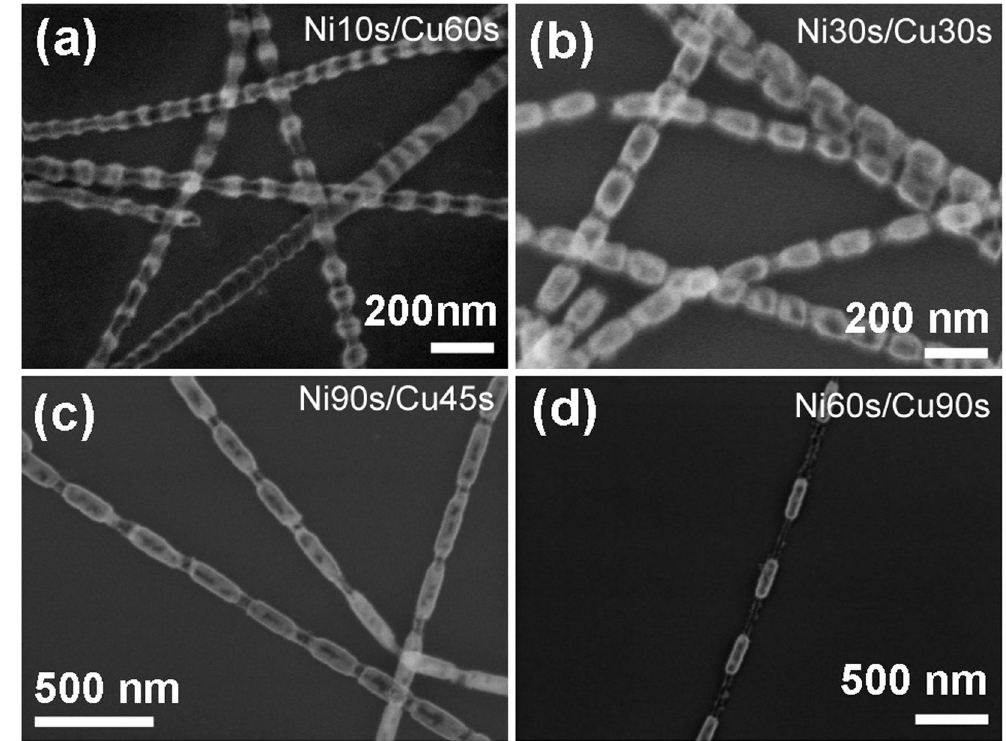
Figure 2. Morphologies of annealed samples with different segment lengths. FE-SEM images of the four kinds Ni/Cu samples after annealing at 700 °C for 2 h in air: ( a ) Ni10s/Cu60s; ( b ) Ni30s/Cu30s; ( c ) Ni90s/Cu45s and ( d ) Ni60s/Cu90s.